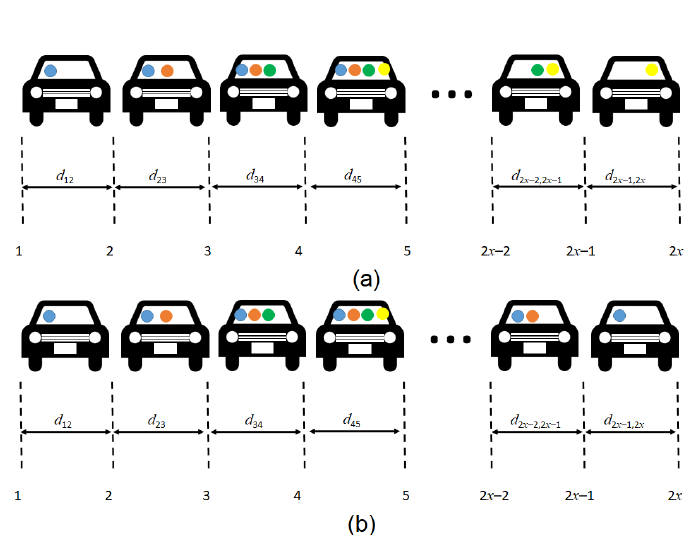
Figure 10. Extending the two types of stable matching. Given x ridesharing passengers, ( a ) Type 1 Match where Passenger blue is rode at point 1 and dropped off at point x + 2, then passenger orange rode at point 2 and dropped off at point x + 2, until passenger yellow rode at point x and dropped off at point 2 x . ( b ) Type 2 Match where Passenger blue rode first and is dropped off last, passenger orange rode second and is dropped off second to the last, until passenger yellow rode last and is dropped off